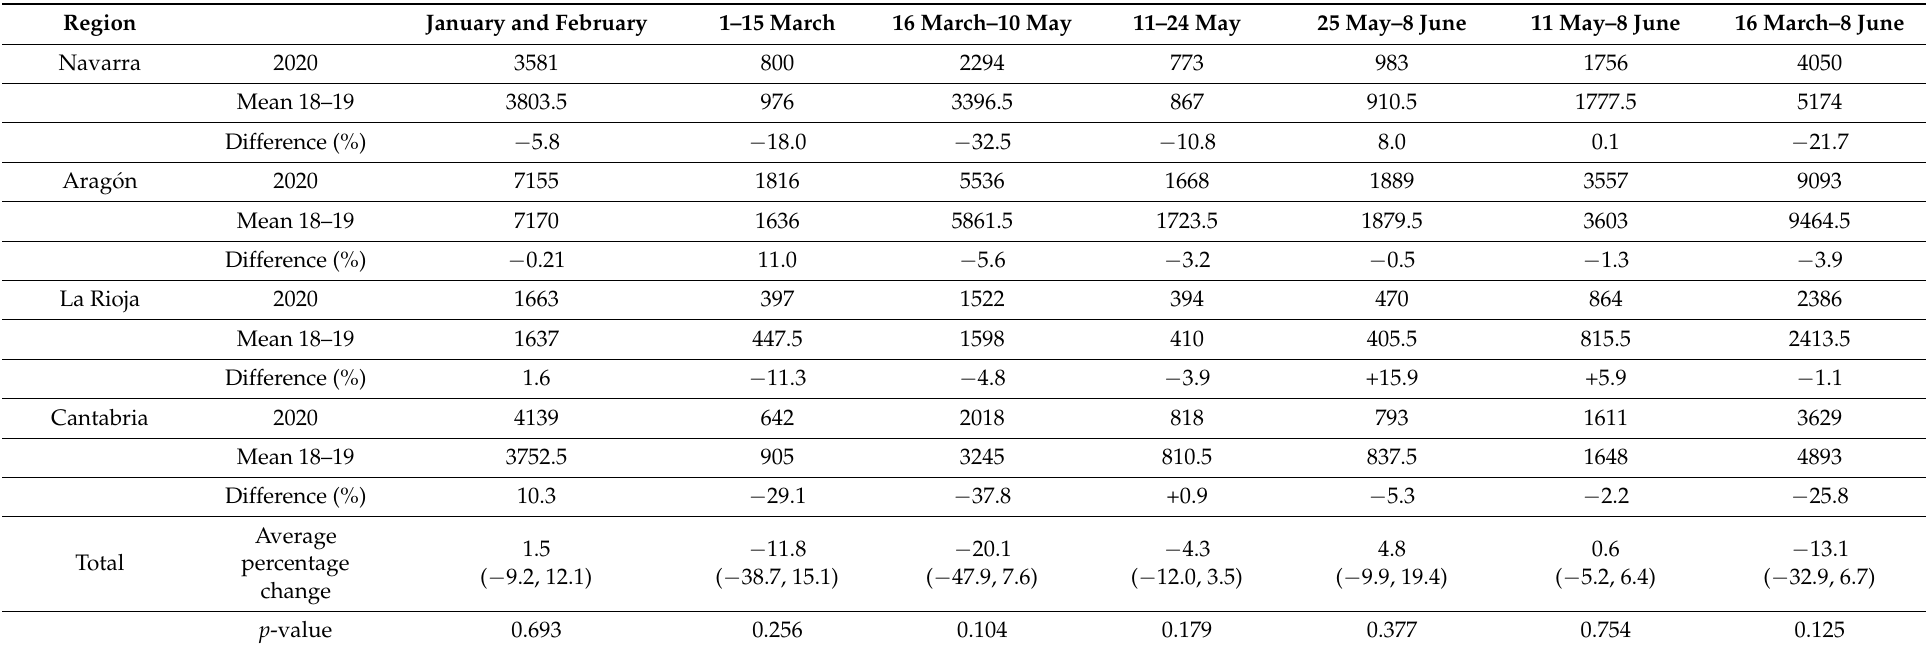
Table 2. Comparison of the evolution of donations by communities according to